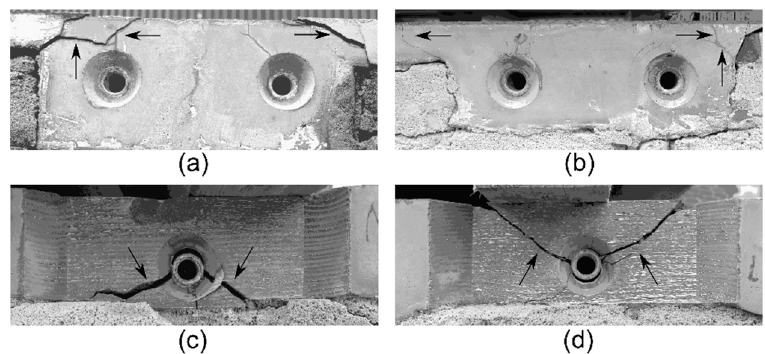
Figure 11. Observed failure modes after shear load testing for cases ( a )–( d ).